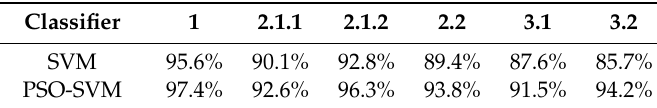
Table 3. Classification rates of each classifier.